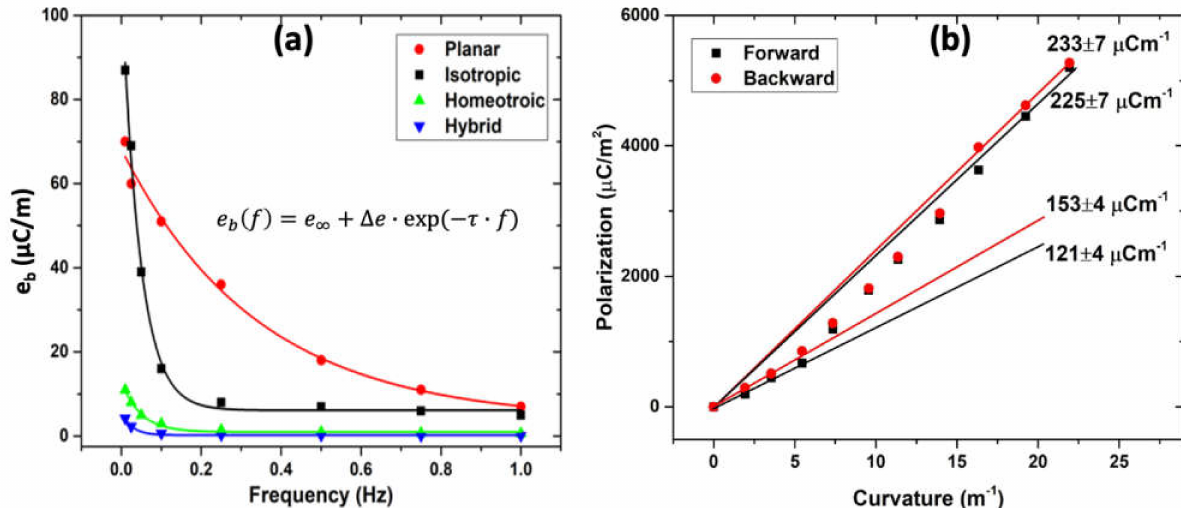
Figure 4. ( a ) Frequency dependence of the flexo-ionic coefficient of differently aligned iLCEs. Symbols are the experimental data points, and the solid lines are fitted curve to a single exponential function with the equation shown in the figure. ( b ) Flexo-ionic polarization versus increasing and decreasing curvature for the isotropic sample. The error values indicated in the figure are calculated by the standard deviation. Black solid squares denote the polarization measured during the curvature increment and solid red circles denote the polarization measured during the curvature